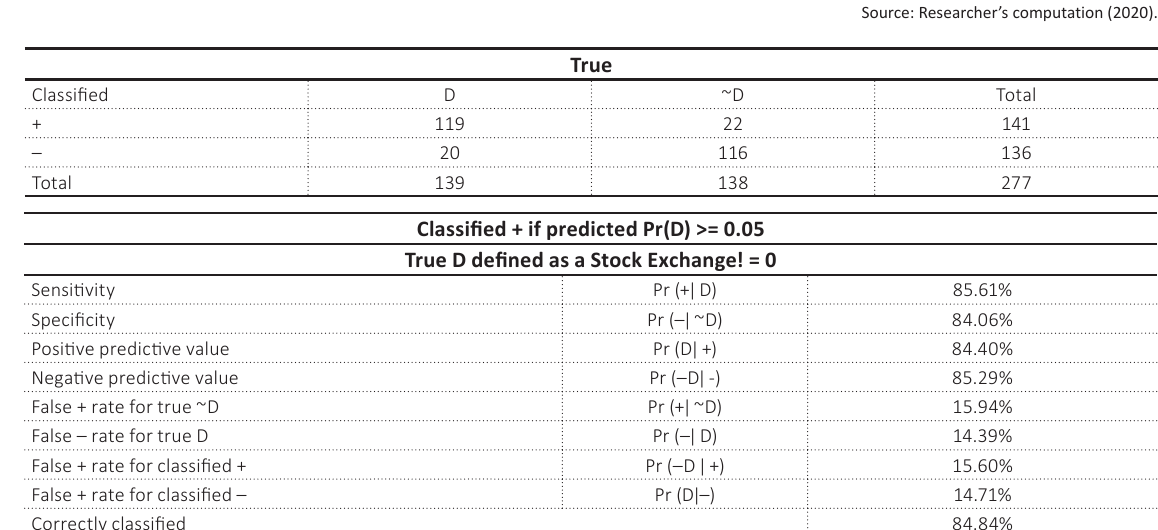
Table 5. Stock exchange fit test classification